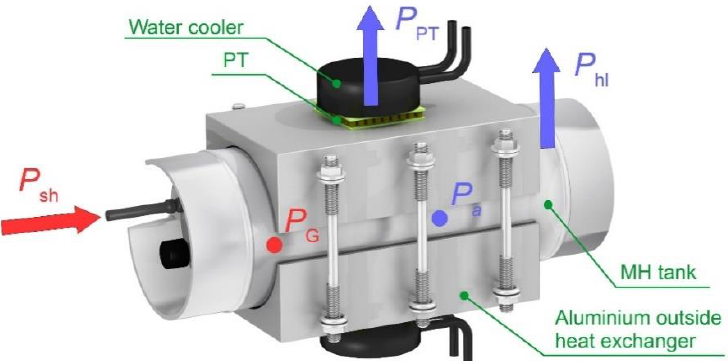
Figure 3. Representation of the heat flows in a separator consisting of a metal hydride tank and thermal management.